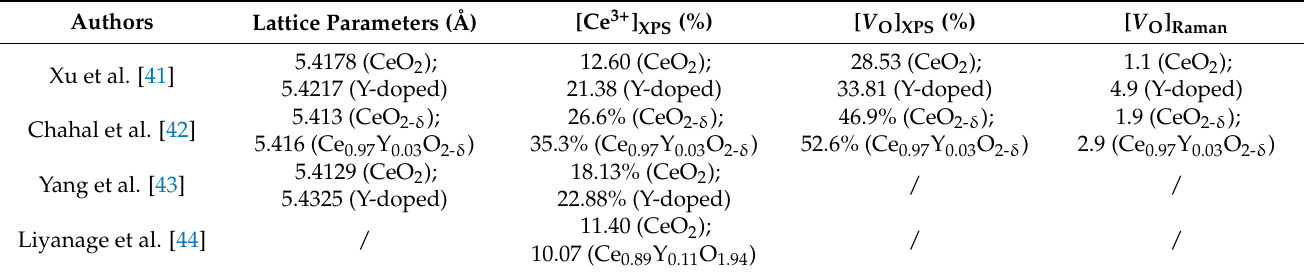
Table 2. Recent literature on the lattice parameters, [Ce 3+ ] XPS , [ V O ] XPS , and [ V O ] Raman of undoped and Y-doped CeO 2